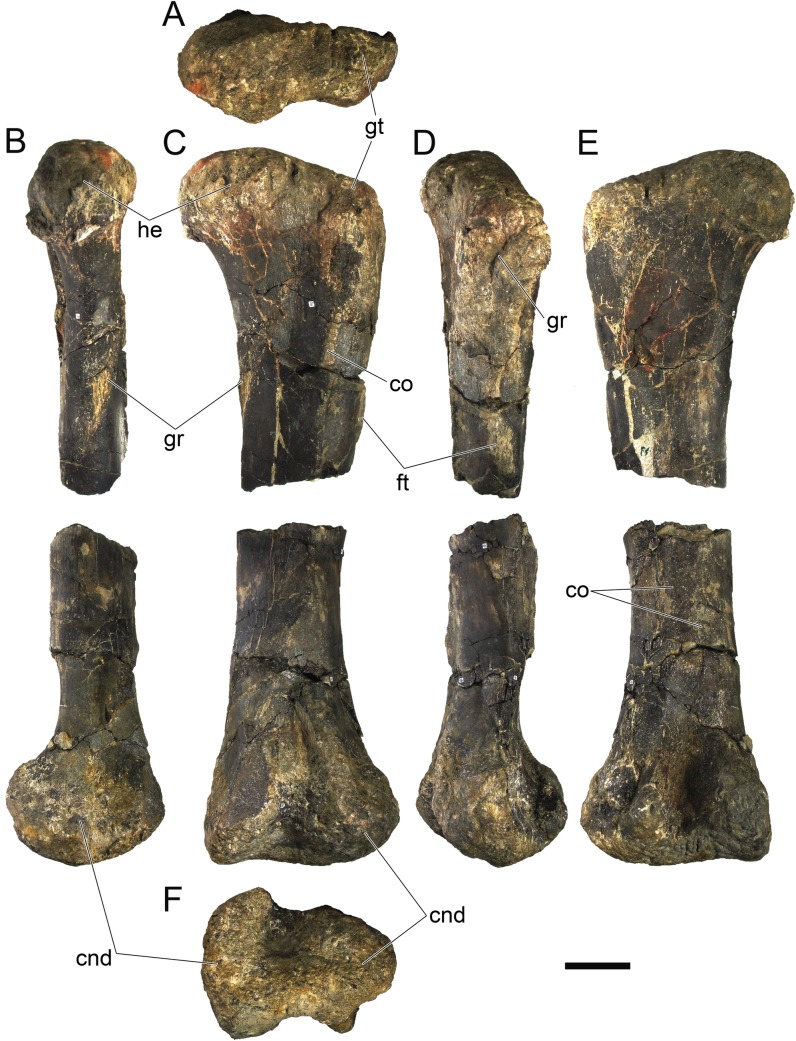
Left femur of Miragaia longicollum MG 4863.A, dorsal, B, medial, C, anterior, D, lateral, E, posterior, and F, ventral view. Cnd, condyle, co, cord, ft, fourth trochanter, gr, groove, gt, greater trochanter, he, femur head. Scale bar equal to 10 cm.